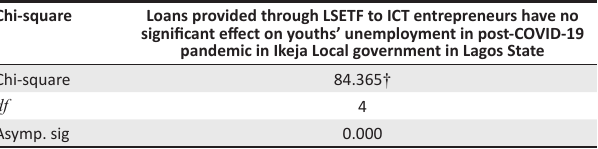
TABLE 5: Chi square ( X 2 ) test statistics (Statistical Package for Social